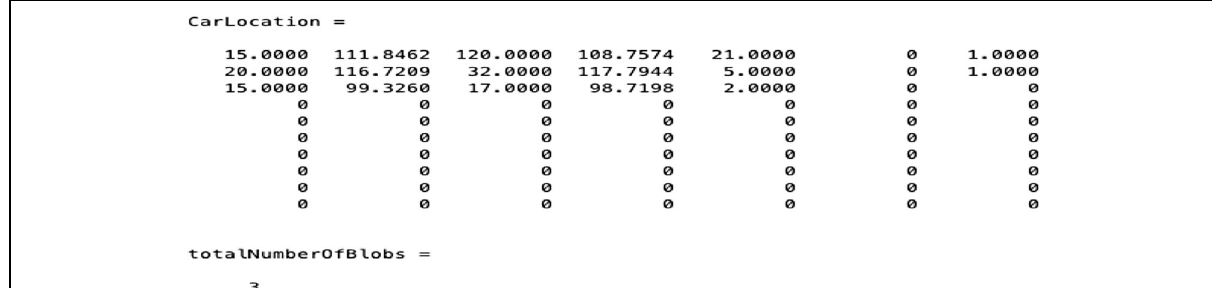
Fig. 14 Array of multiple vehicle coordinates and vehicle